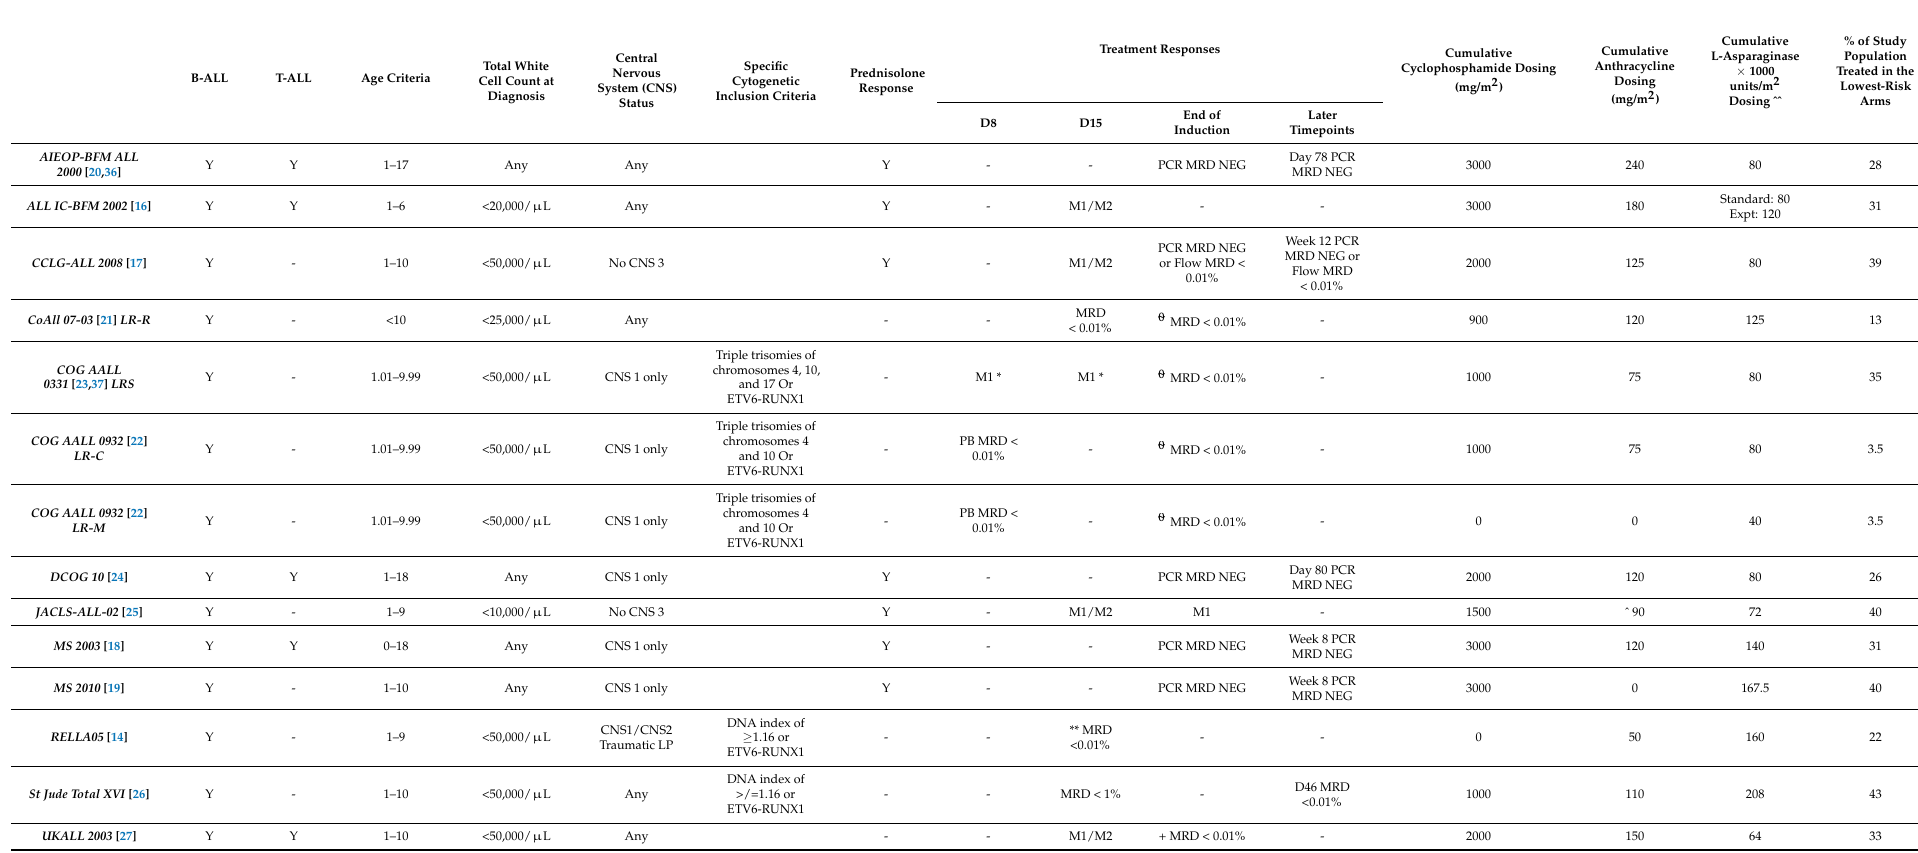
Table 2. Risk stratification criteria, cumulative chemotherapy dosing and proportions of patients treated in lowest-risk arms . B-ALL T-ALL